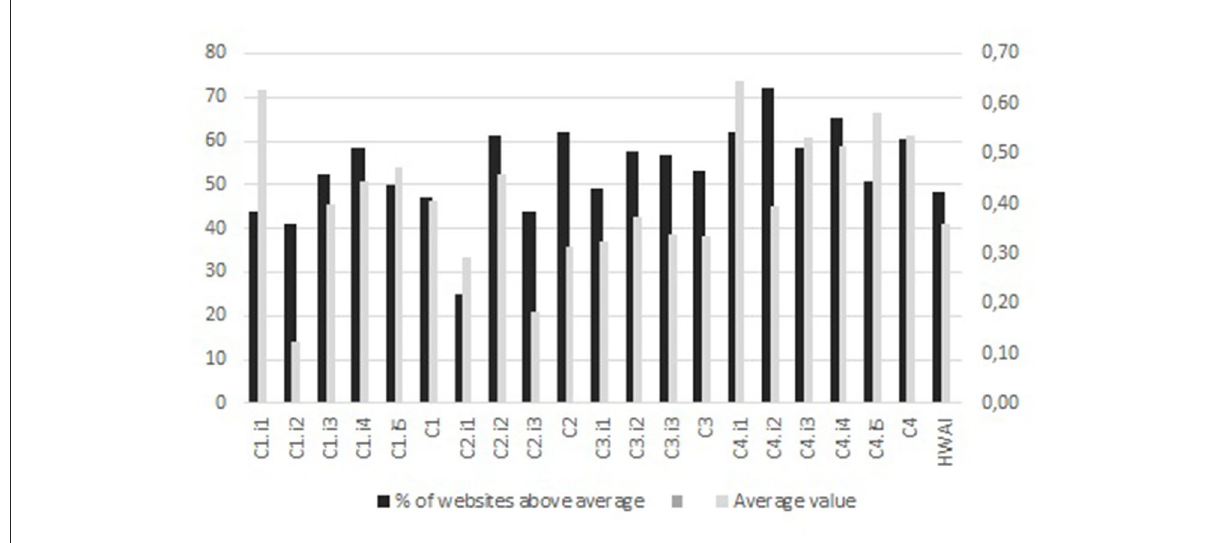
FIGURE2 Criteria and indicators average values and percentage of websites that score above the average value.